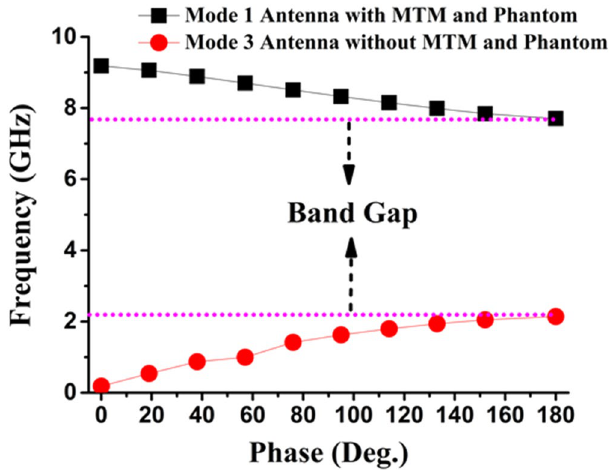
Figure 14. Dispersion diagram of the proposed